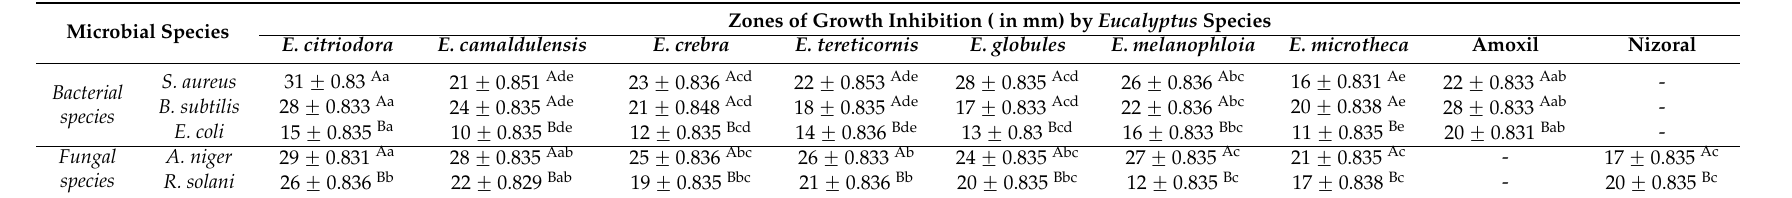
Table 3. Comparative antimicrobial activities of essential oils of Eucalyptus